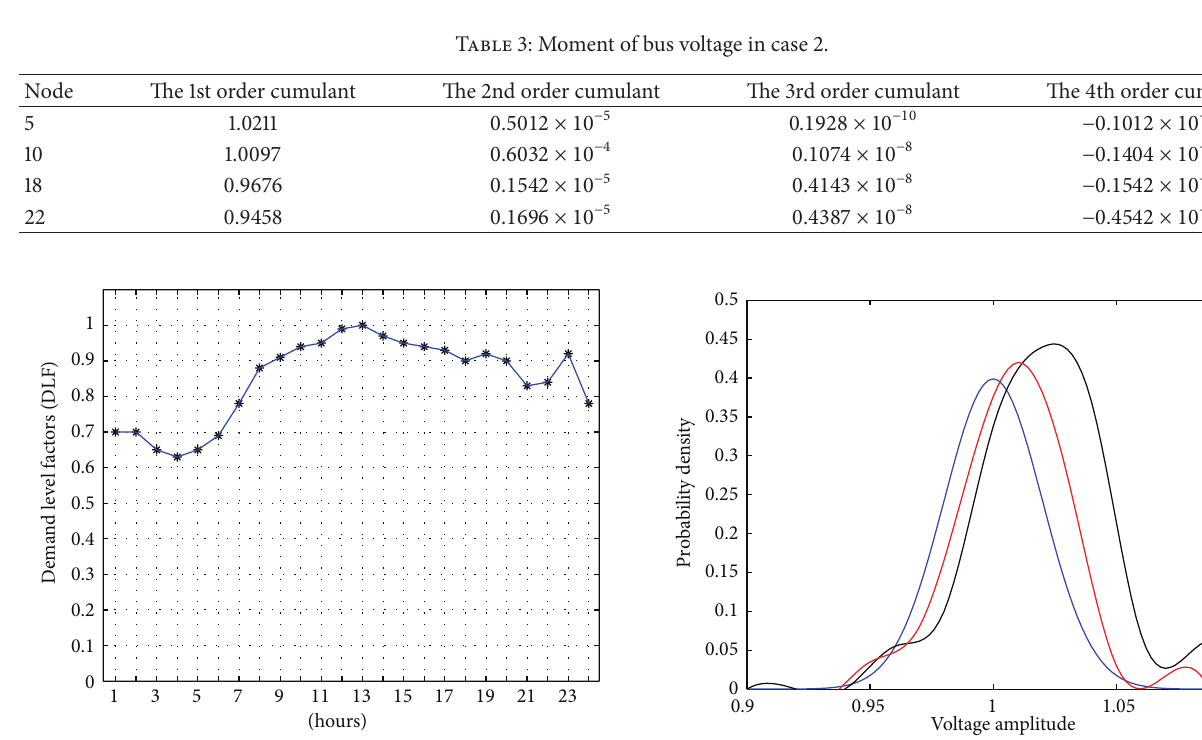
Figure 3: The variations of DLF ℎ in each demand level.